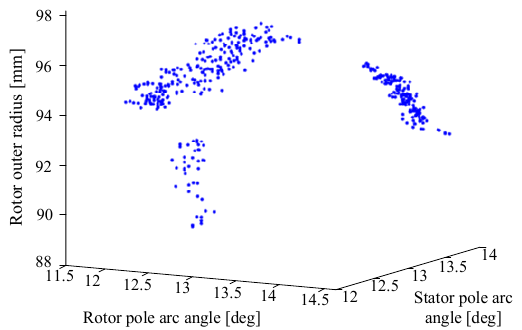
Figure 5. Illustration of static design results with respect to the three geometry parameters with highest correlation to average torque.